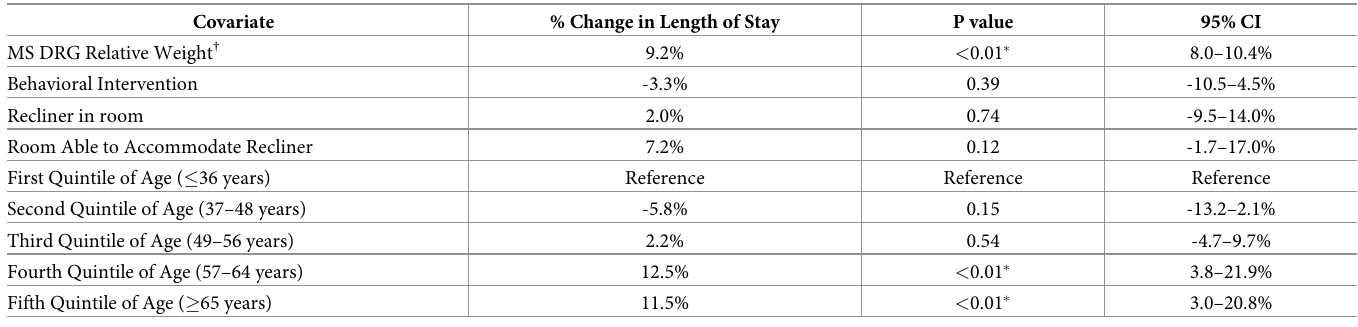
Table 2. Multivariate analysis of factors associated with length of stay (N =